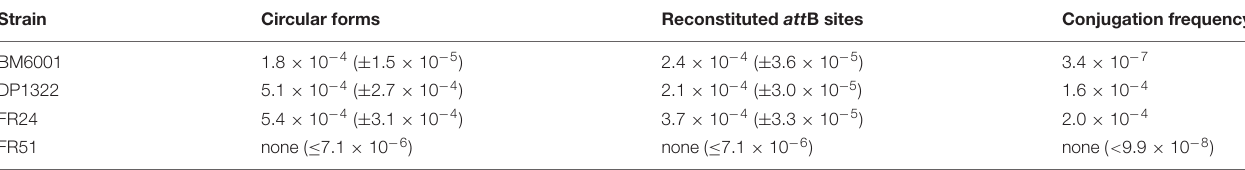
TABLE 3 | Real-time PCR quantification of Tn 5253 circular form and reconstituted att B a . Strain Circular forms Reconstituted att B sites